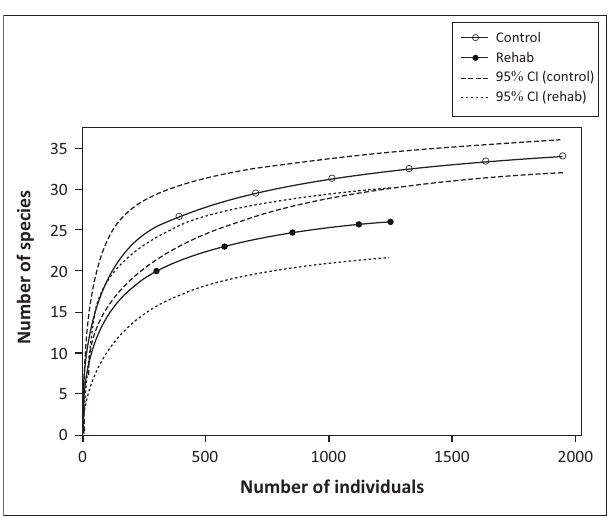
FIGURE 2: Rarefaction curves with 95 % confidence intervals comparing species richness in the control and rehabilitated (rehab) sites. Species richness should be compared for equal numbers of species in each